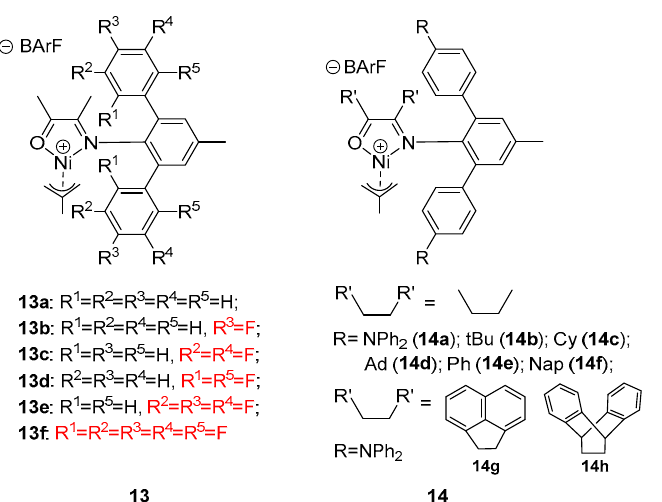
Figure 11. Cationic α -imino-ketone nickel catalysts 13a – f and 14a – h (Cy = cyclohexyl, Ad = adamantyl, Nap = Naphthyl).